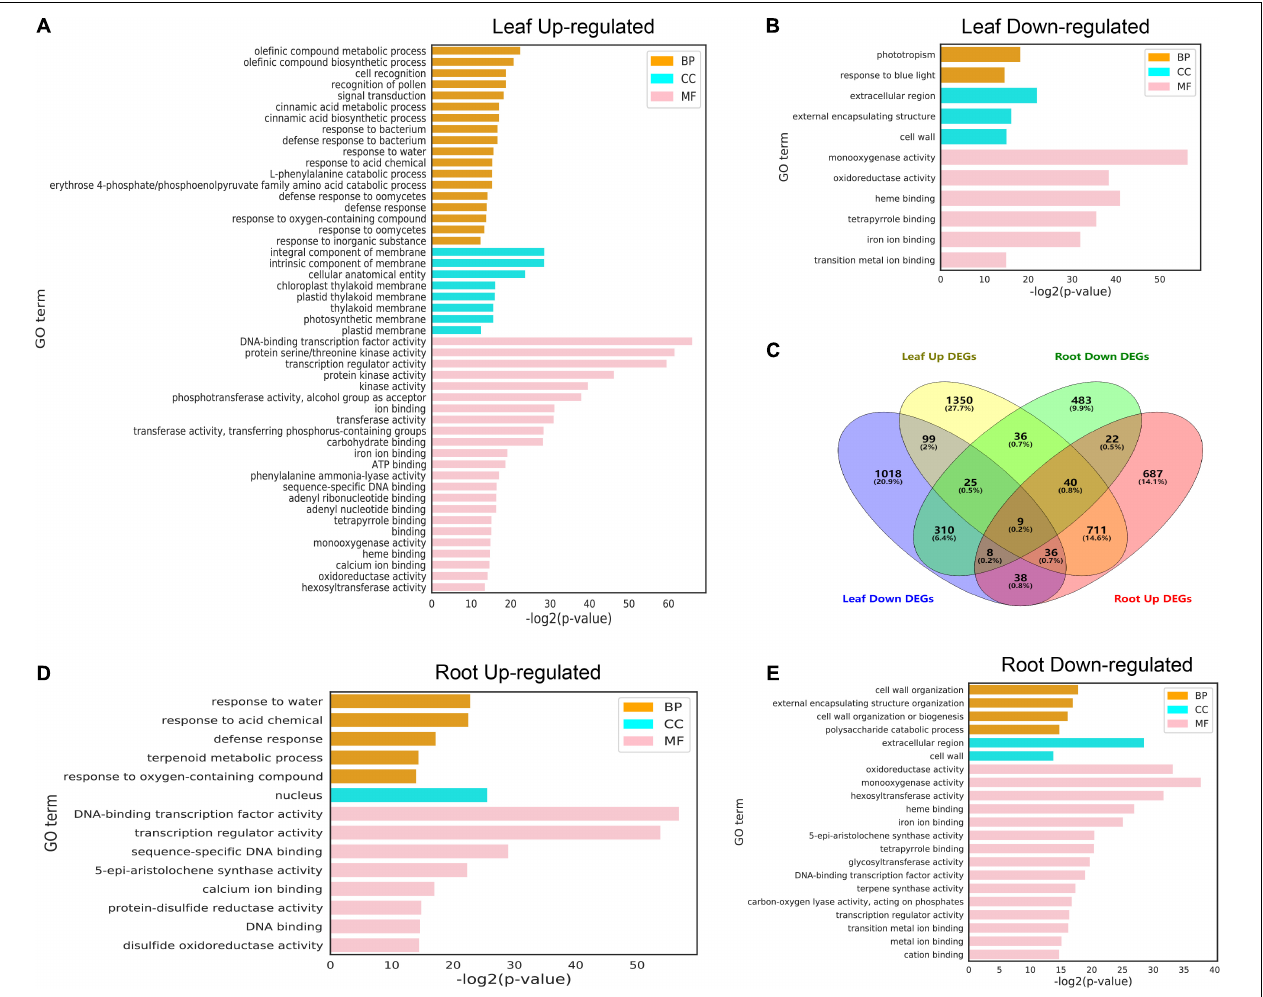
FIGURE 5 | Gene ontology terms for differentially expressed genes (DEGs) under cold stress conditions. (A,B) GO terms of upregulated and downregulated DEGs (FDR < 0.01) identified from leaves at different treatment time points. (C) Venn diagram of DEGs between the two tissues subjected to cold stress at six different time points. (D,E) GO terms of upregulated and downregulated DEGs (FDR < 0.01) identified from roots at different treatment time points. The complete list of DEGs and GO terms for enrichment analysis is shown in Supplementary Tables 8–11